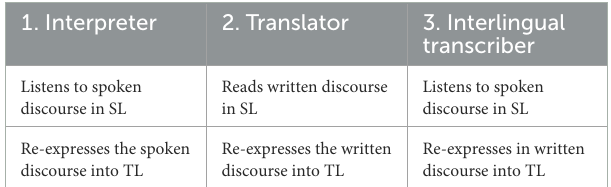
TABLE 5 FTT as a hybrid T&I